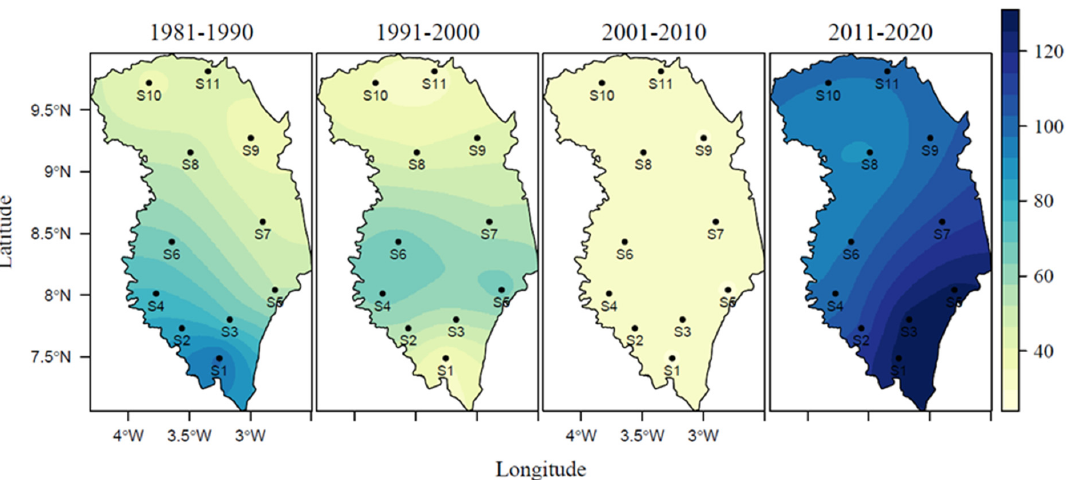
Figure 6. Spatial distribution of the total annual precipitation from very heavy rain days (R99p) (mm) per decade in the Zanzan region. Stations (S1 = Koun Fao, S2 = Kouassi-datékro, S3 = Tanda, S4 = Sandegué, S5 = Bondoukou, S6 = Nassian, S7 = Sapli, S8 = PN Comoé S1, S9 = Bouna, S10 = Téhini, S11 = Doropo).